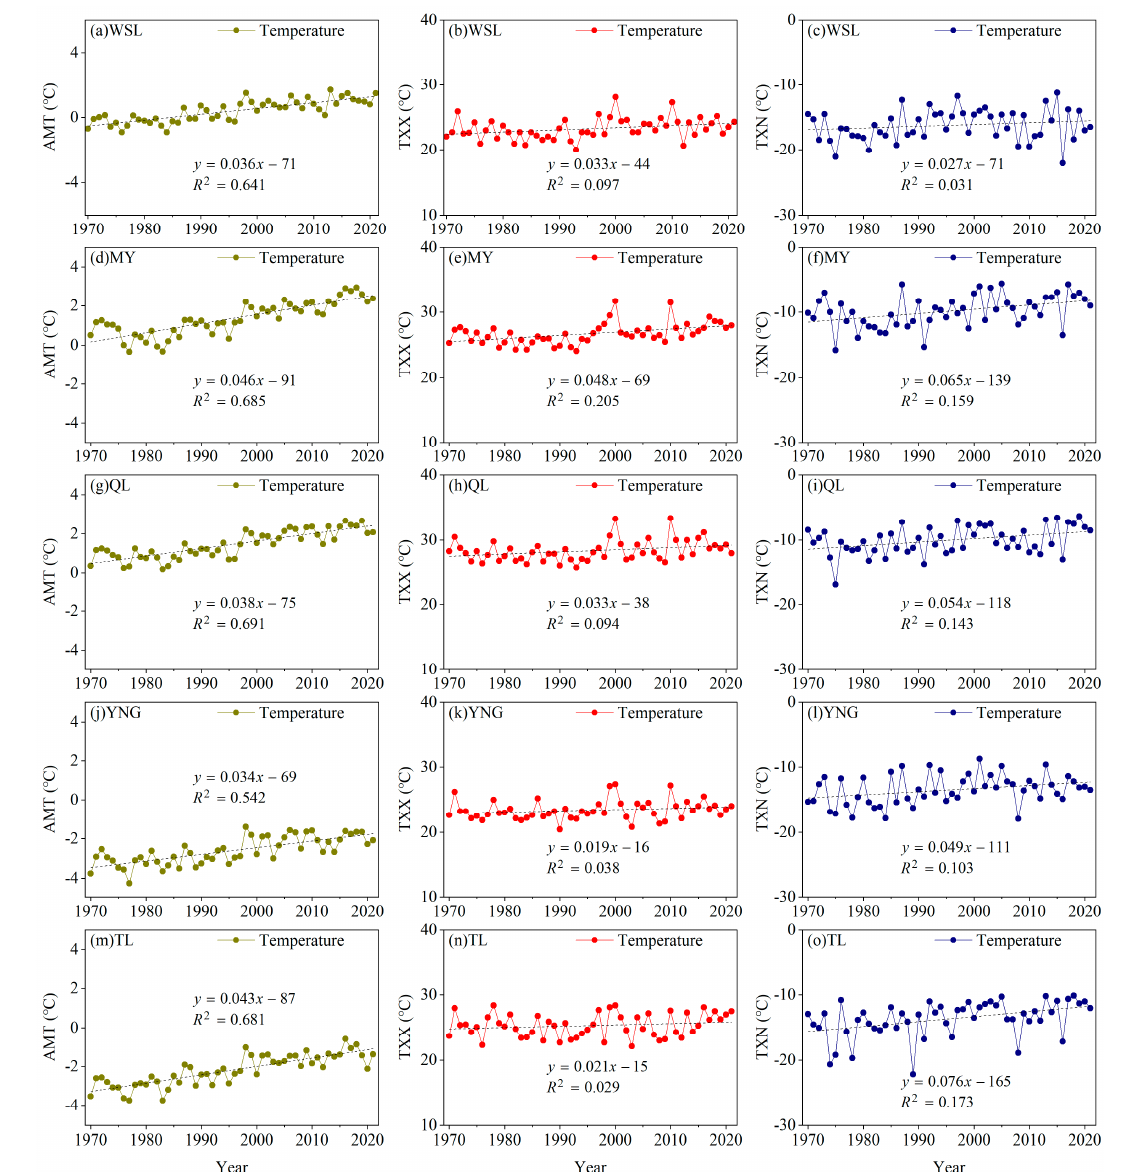
Figure 6. Temporal variations in temperature indices at meteorological stations in the QM region. The stations are, WSL: Wushaoling; MY: Menyuan; QL: Qilian; YNG: Yeniugou; TL: Tuole. ( a – c ) WSL; ( d – f ) MY; ( g – i ) QL; ( j – l ) YNG; ( m – o ) TL. Definitions of these temperature indices are given in Table